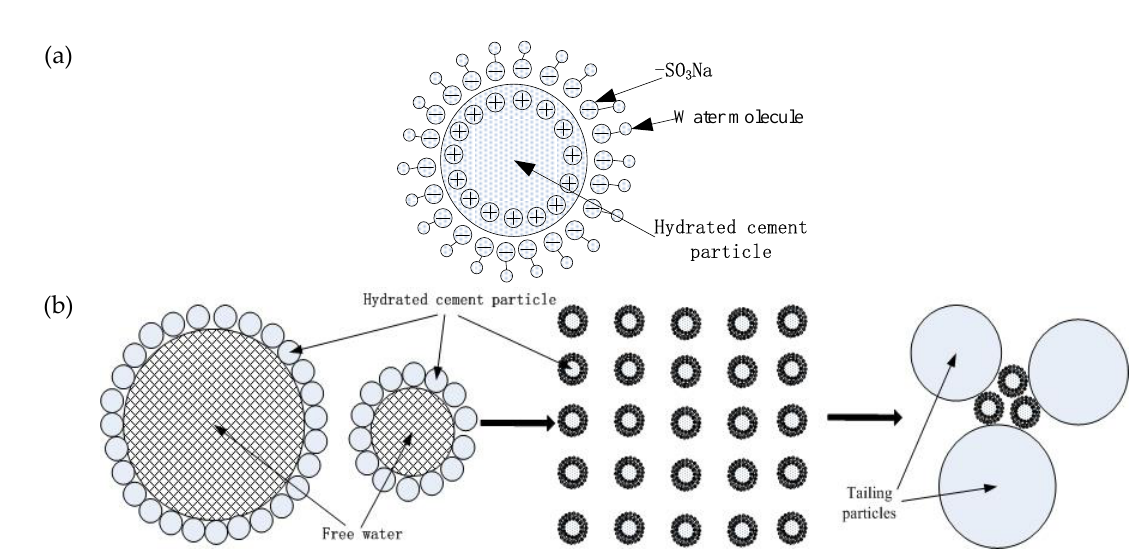
Figure 11. Physico-chemical mechanism of the effect of polynaphtalene sulfonate on the strength of CPB: ( a ) adsorption effect and ( b ) filling effect.